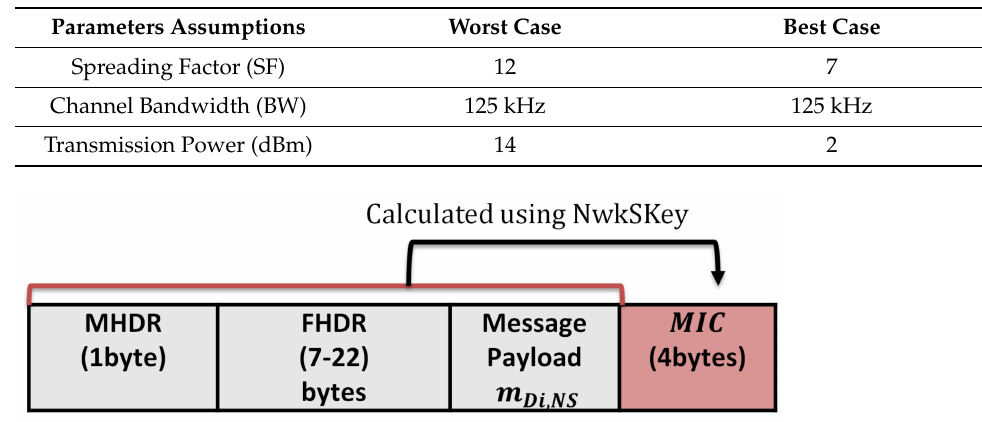
Figure 16. The original message format of